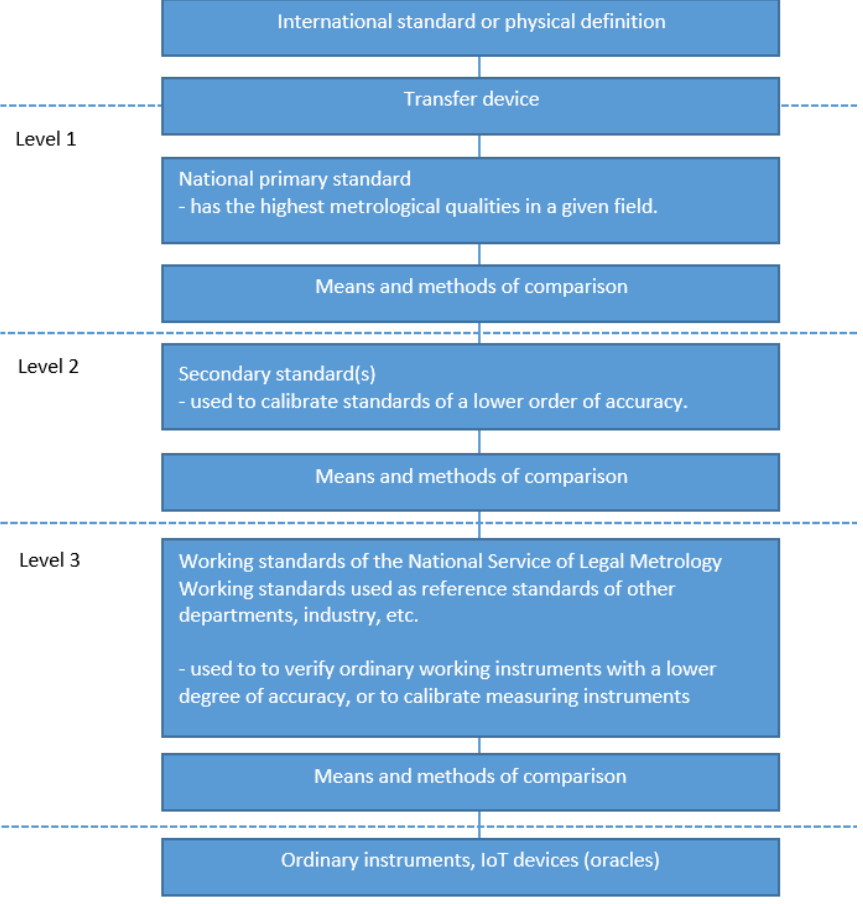
Figure 2. National hierarchy scheme and role of IoT device [22].